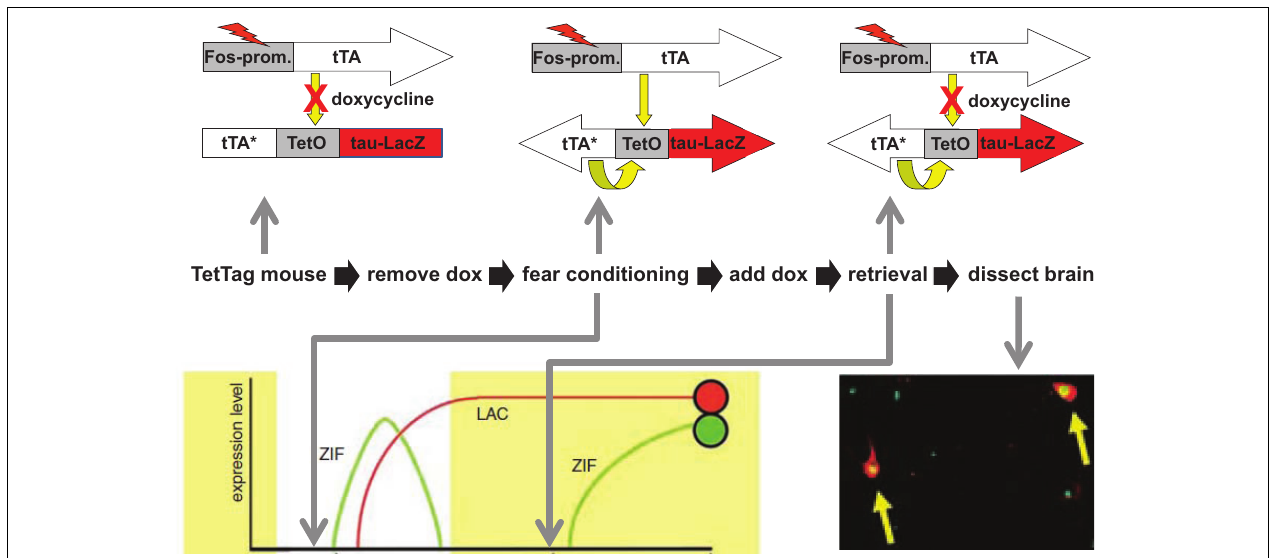
conditioning (while off Dox) were tagged with long-lasting expression of taulacZ (LAC; red circle). Mice were put back on food with doxycycline and a retrieval test was done 3 days later, followed by analysis of the brains 1 h after retrieval for expression of lacZ and zif268. Neurons activated during learning expressed lacZ and those active during retrieval expressed zif268 (ZIF; green circle). The number of neurons in the amygdala that expressed both LAC and ZIF, indicating that they were activate during both learning and retrieval, was positively correlated with the strength of the fear memory that the animal